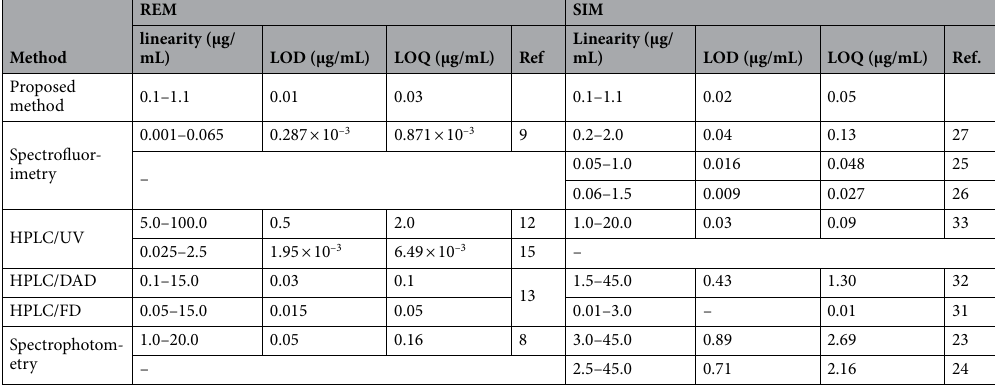
Table 6. Comparison between the proposed spectrofluorimetric method and other reported